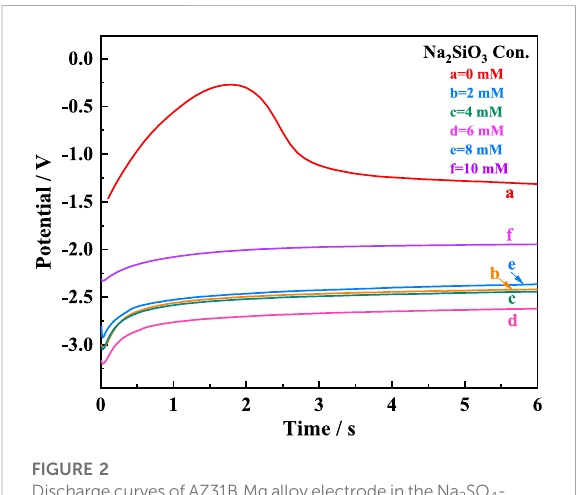
FIGURE 3 Nyquist curves of EIS for AZ31B Mg alloy electrodes in the Na 2 SO 4 -NaNO 3 composite electrolyte with different at a current 2 SiO 3 concentrations of Na 2 SiO 3